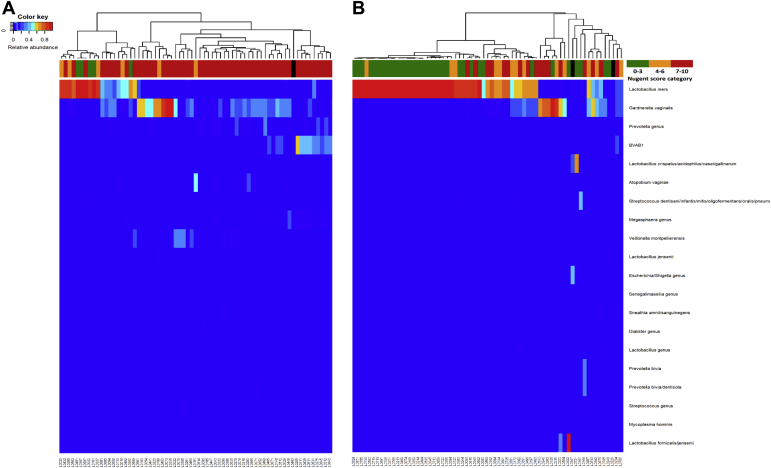
Heatmaps of 16S rRNA gene sequencing data pre- and posttreatmentA–B, Heatmaps at the pretreatment (A) and the posttreatment visit (B) depicting the 20 amplicon sequence variants with the greatest mean relative abundance on the y-axis and samples (N=67 at each visit) on the x-axis. The dendrogram above the heatmap depicts vaginal microbiota clusters based on Euclidean distance. The bar below the dendrogram depicts Nugent score categories (see legend; black means no score available).BVAB1, bacterial vaginosis-associated bacterium type 1.Verwijs et al. Impact of oral metronidazole treatment on the vaginal microbiota and correlates of treatment failure. Am J Obstet Gynecol 2020.